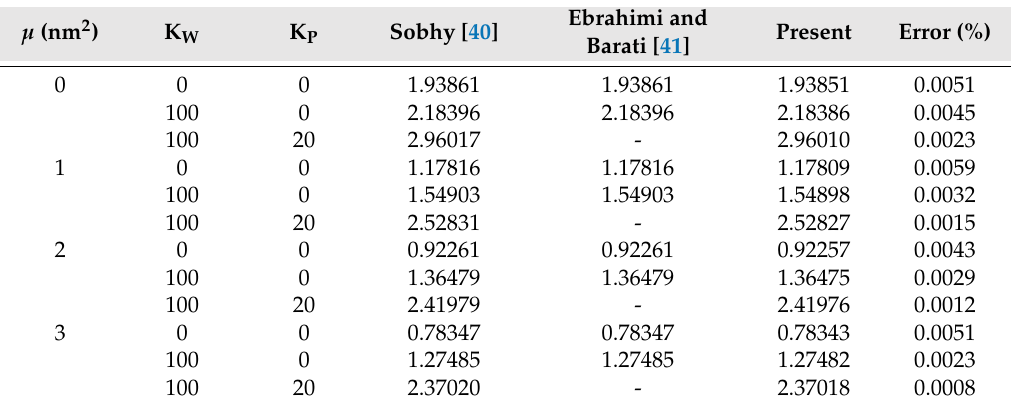
Table 2. Dimensionless natural frequencies of the square graphene sheet for different nonlocal and foundation parameters ( a / h = 10).